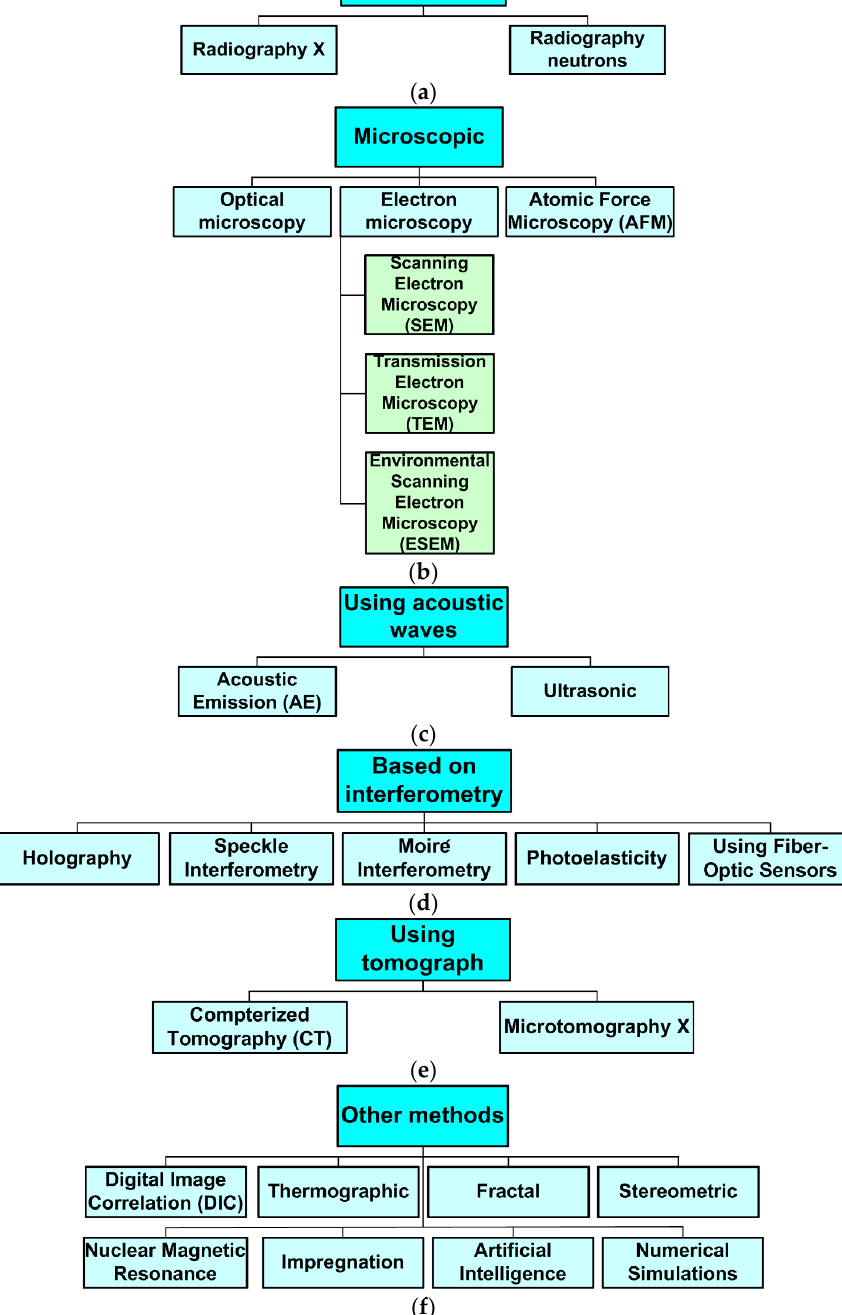
Figure 10. The most important methods for the detection and analysis of microcracks and cracks in cement concretes: ( a ) [185–193], ( b ) [173,194–204], ( c ) [204–213], ( d ) [177,214–217], ( e ) [179–182] and ( f )